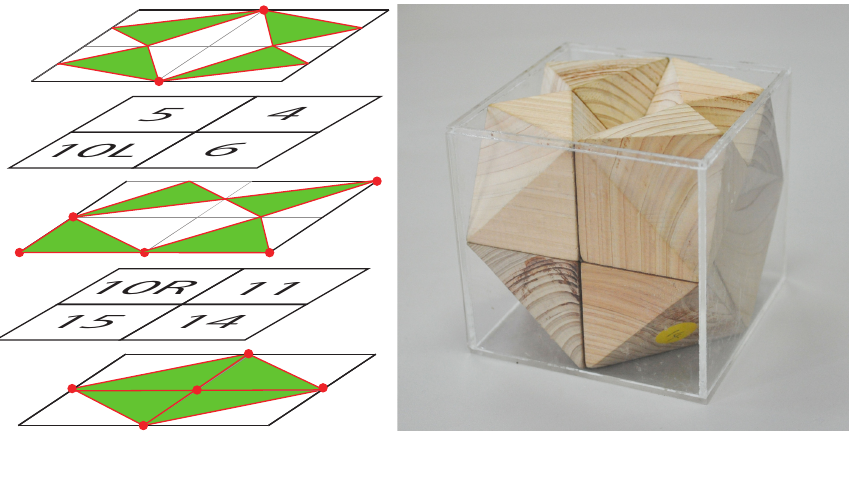
Figure 14. A solution of the puzzle of minimal convex imaginary